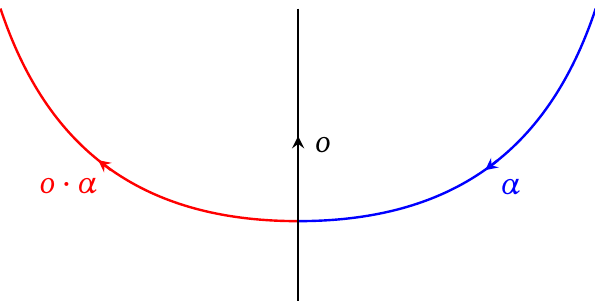
Figure 2: An outer-automorphism twist line (shown in black) acts on the element of (cid:98) Z G carried by a K1-chain (shown in red and